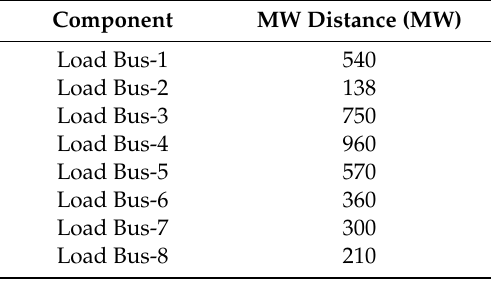
Table 4. MW distance from instability for each load location.